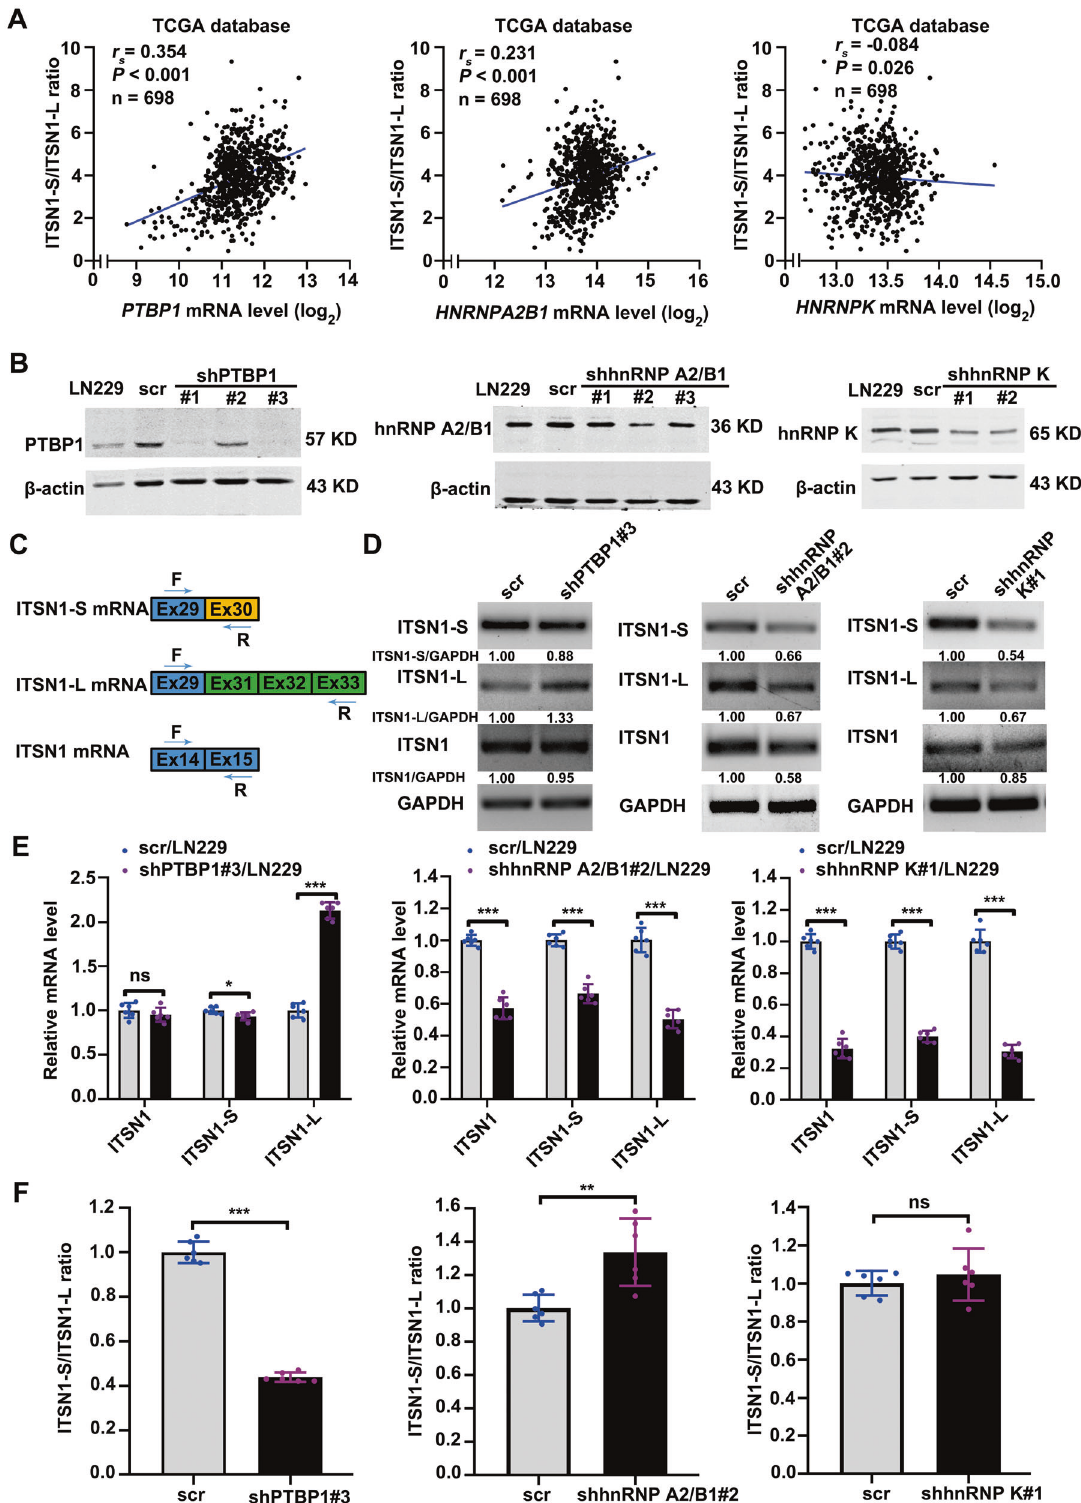
Fig. 3 Knock-down of PTBP1 downregulated the ratio of ITSN1-S/ITSN1-L. A Scatter plot indicating the correlation of mRNA level of PTBP1, hnRNP A2/B1, and hnRNP K with ITSN1-S/ITSN1-L expression ratio using glioma RNA-Seq data from TCGA database. B Establishment and veri fi cation of stable cell lines underexpressing the 3 RBPs above. β -actin was used as an internal control. C Graphical representation of PCR primers for speci fi c detection of ITSN1 and ITSN1-S, ITSN1-L isoforms. D RT – PCR detection of knockdown of the 3 RBPs above in LN229 cells on the expression levels of ITSN1, ITSN1-S, and ITSN1-L. E , F RT – qPCR analysis showing changes in the ITSN1-S, ITSN1-L, and total ITSN1 mRNA level ( E ) as well as the ratio of ITSN1-S/ITSN1-L ( F ) upon silencing of the 3 RBPs above in LN229 cells. Values were expressed as mean ± SD from six independent experiments in ( E ) and ( F ) (two-tailed Student ’ s t test, * P < 0.05, ** P < 0.01, *** P < 0.001, ns, no signi fi cance).